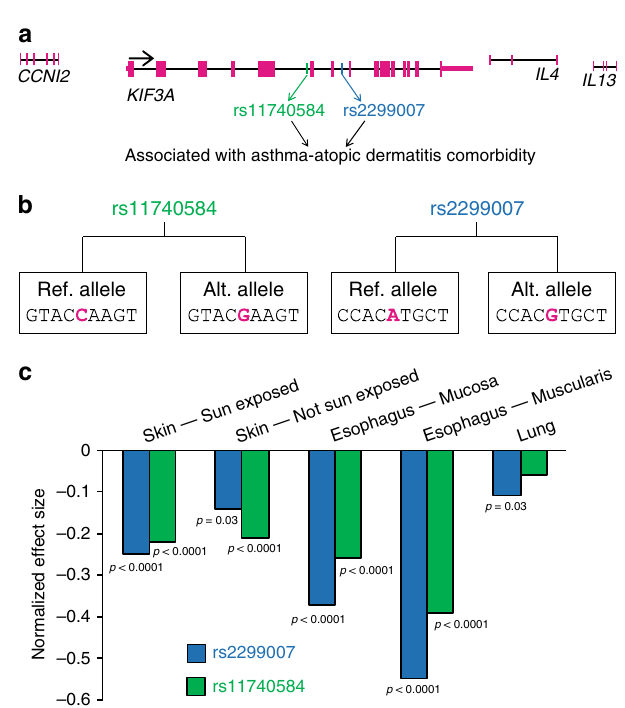
Fig. 1 KIF3A SNPs rs11740584 and rs2299007 create novel CpG sites and are eQTL. a Genomic organization of the human KIF3A and neighboring genes on chromosome 5q31 with the location of SNPs rs11740584 and rs2299007 marked. Magenta bars indicate exons. b Alternate alleles